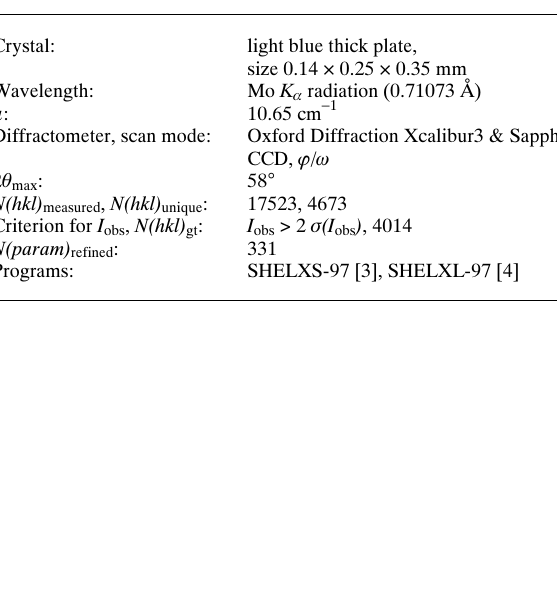
Table 2. Atomic coordinates and displacement parameters (in Å 2 ) . Table 1. Data collection and